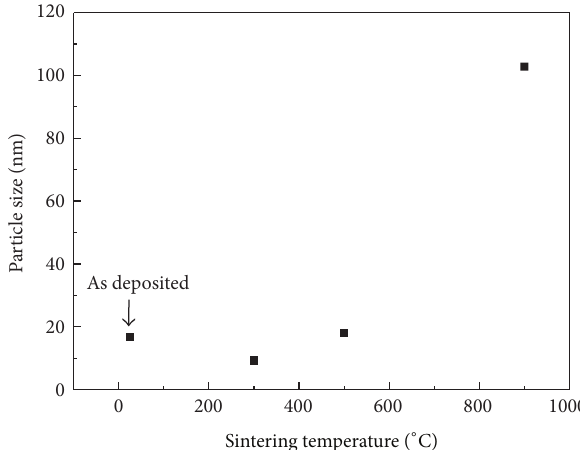
Figure 9: Crystallite size versus sintering temperature calculated from X-ray diffraction data of electrodeposited CeO 2 films at 70 ∘ C with applied current density of − 0.06mA/cm 2